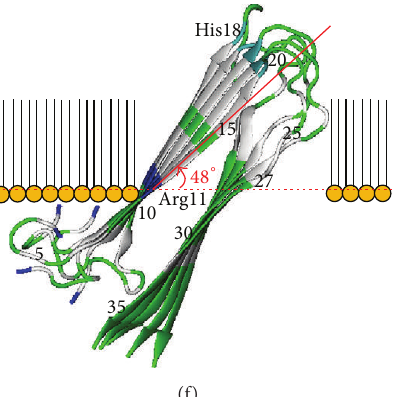
Figure 7: Determination of the orientation of human IAPP aggregates at the lipid/water interface. (a) Definition of three orientation angles ( 𝜙 , 𝜃 , 𝜓 ) for Euler transformation from the laboratory to the molecular frame. (b) psp (chiral) SFG spectrum of hIAPP aggregates in the amide I region. 𝐴 and 𝐵 denote the characteristic peaks for amide I symmetric and antisymmetric modes. (c) Scheme showing the divide- and-conquer method for simulations of the SFG spectra from calculations of hyperpolarizability derivatives with respect to normal mode displacements in human IAPP aggregates. (d) Relationship between the intensity ratio of the 𝐵 mode to the 𝐴 mode and orientation angle 𝜓 . The blue curve is obtained analytically from (1), and the red curve is obtained numerically. (e) Chiral SFG spectra of human IAPP aggregates simulated for various orientations at the interface. (f) Visualized orientation of the human IAPP aggregates at the lipid/aqueous interface. Adapted from [65] with permission. Copyright 2012